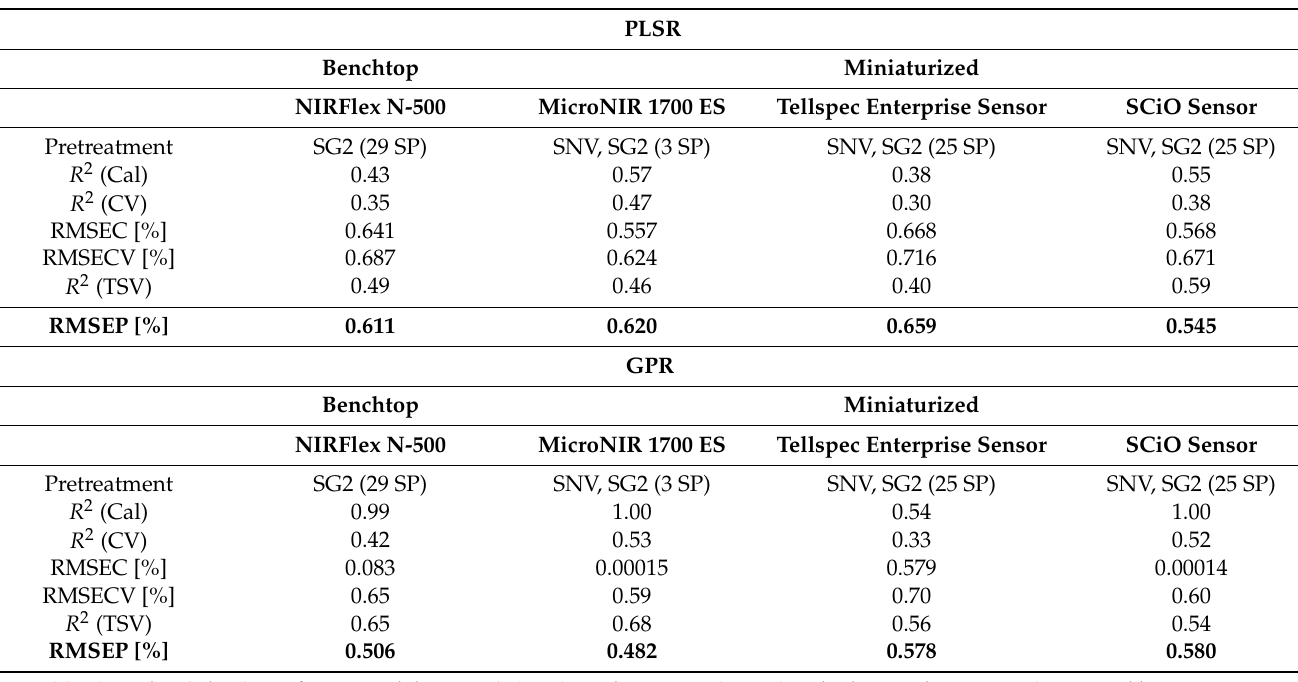
Table 2. The parameters of the best performing regression models for the analysis of protein content (range: 19.3–23.0% ( w / w )) in intact